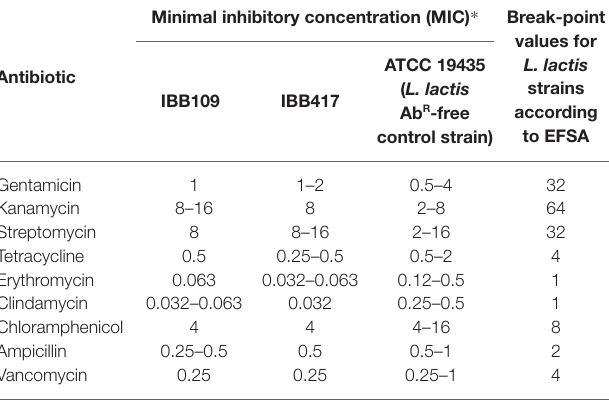
TABLE 2 | Antibiotic resistance of L. lactis IBB109 and IBB417 strains. Minimal inhibitory concentration (MIC) Antibiotic